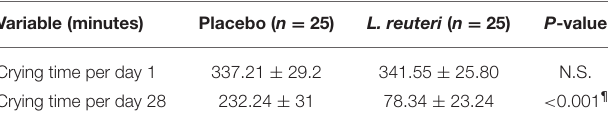
TABLE 3 | Crying and fussing time (mean minutes per days) at day 1 and at day 28 in placebo and L. reuteri group. Variable